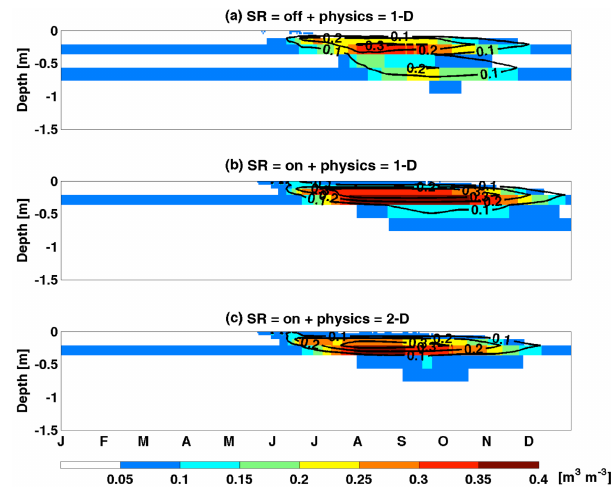
Figure 12. Same as Fig. 6 except for liquid